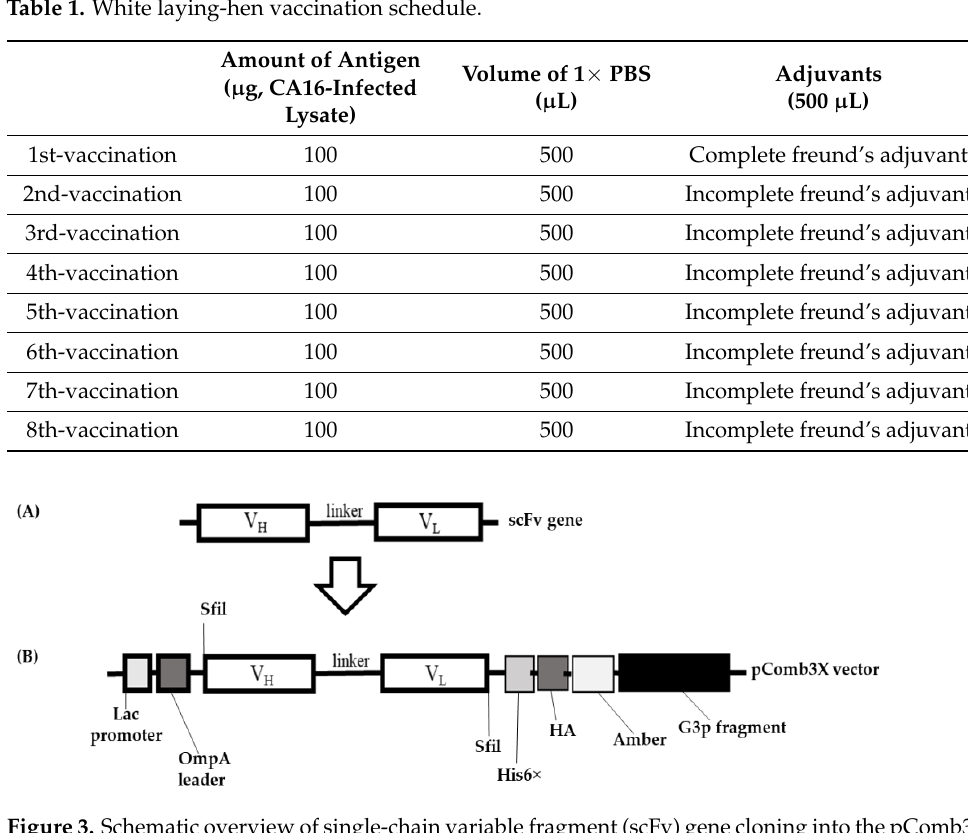
Table 1. White laying-hen vaccination schedule.